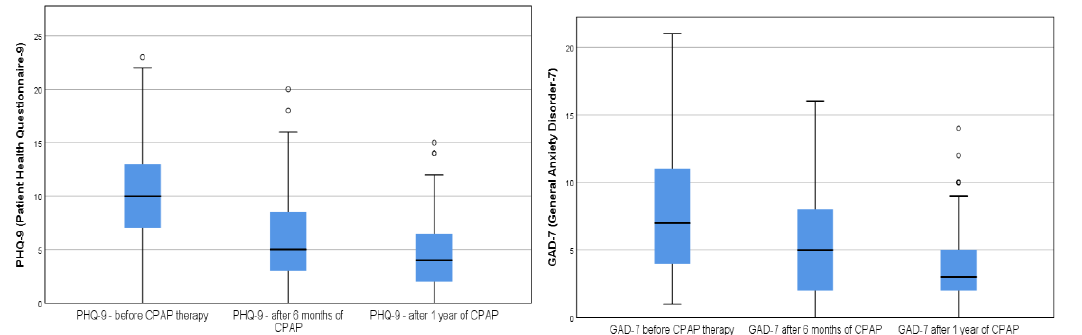
Figure 1. Boxplot showing the difference in PHQ-9 and GAD-7 progression following CPAP therapy. PHQ-9, patient health questionnaire; GAD-7, generalized anxiety disorder questionnaire. The circles represent the outliners of the boxplot.